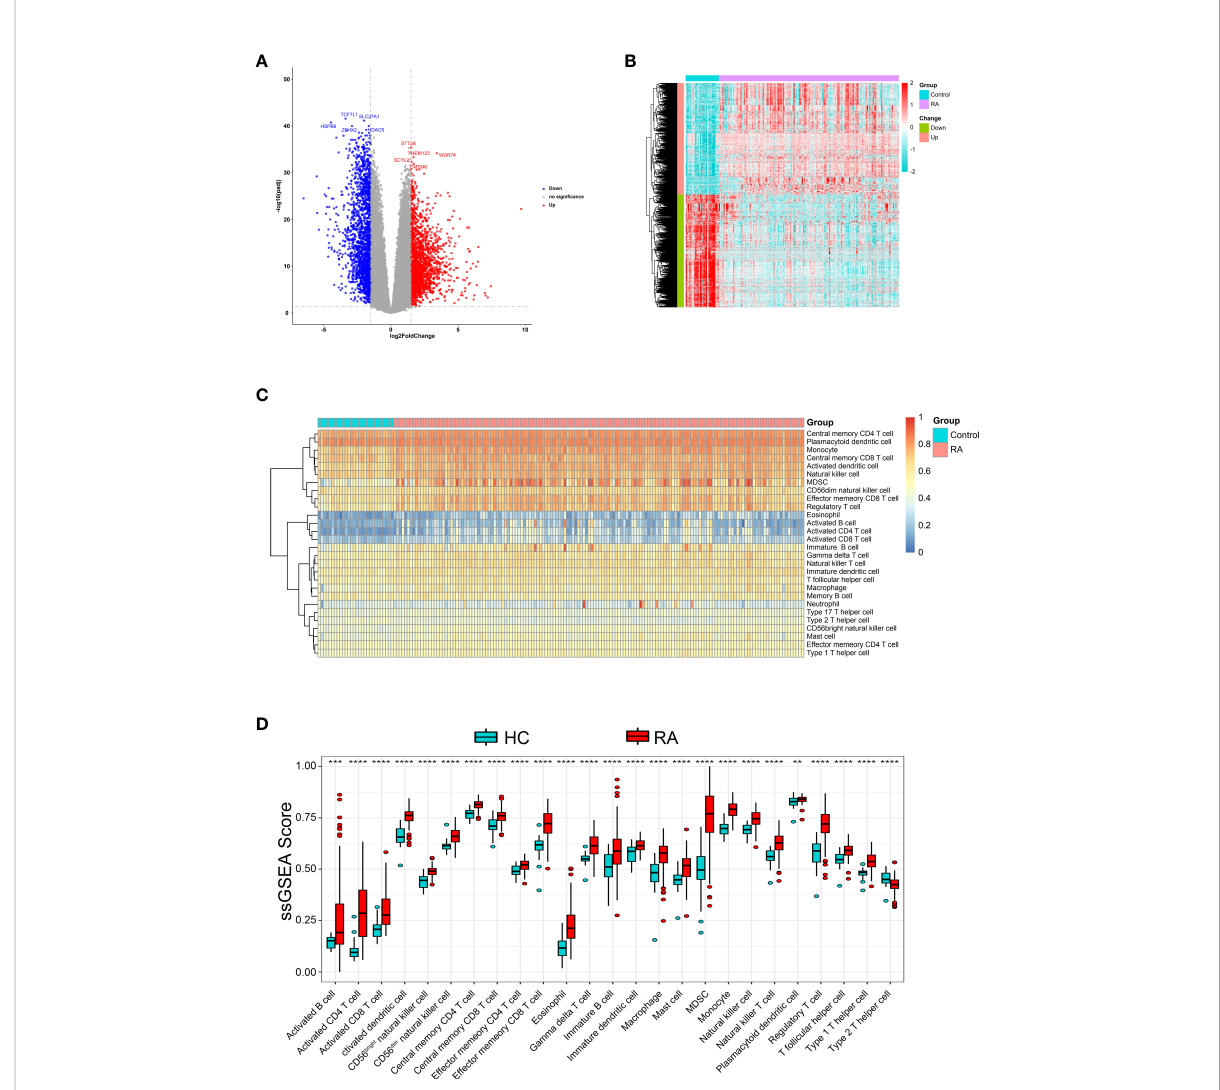
FIGURE 1 Identi fi cation DEGs and the immune in fi ltration in RA. (A) The volcano plot and (B) heatmap to show signi fi cant DEGs between RA and HC samples (C) Heatmap of the immune in fi ltration pro fi les of RA and HC samples analyzed by ssGSEA score-based method. (D) Comparison of immune cell in fi ltration between RA and HC samples. **p < 0.01, ***p < 0.001 and ****p <